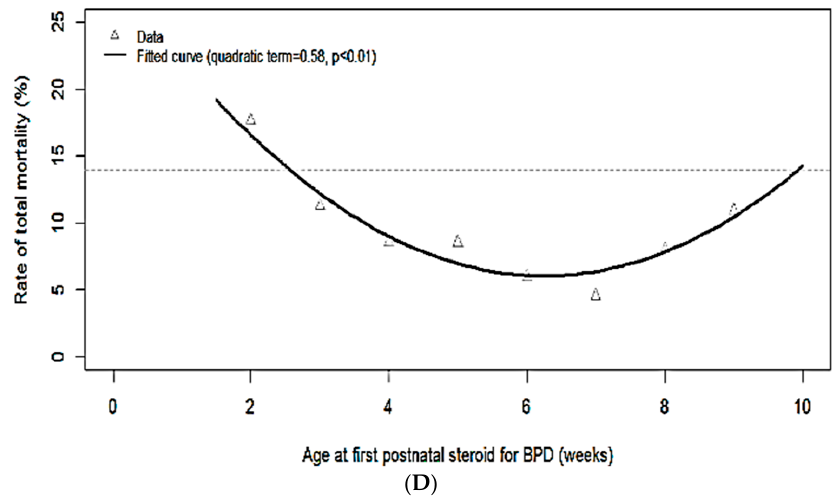
Figure 2. Relationship of the outcomes with the postnatal age of starting sPNS on the unadjusted univariate analysis. A linear relationship between initiation of sPNS and a composite of mortality or sNDI, sNDI, motor composite < 70 ( A – C ) while a U-shaped relationship for mortality ( D ) is noted Table 4. Adjusted odds of neurodevelopmental outcomes for the age at first systemic postnatal ster-